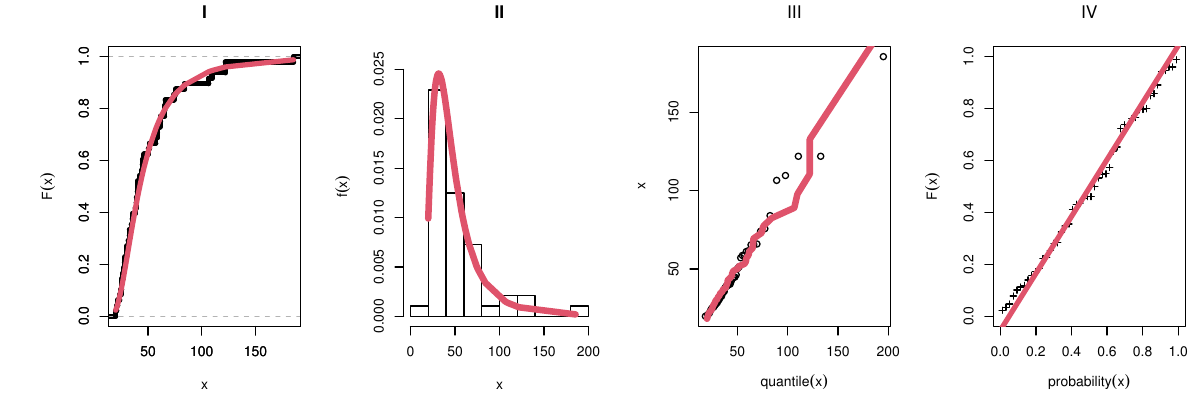
Figure 3. Fitting of ( I ) ecdf, ( II ) epdf, (III ) QQ and ( IV ) PP plots for the flood data.